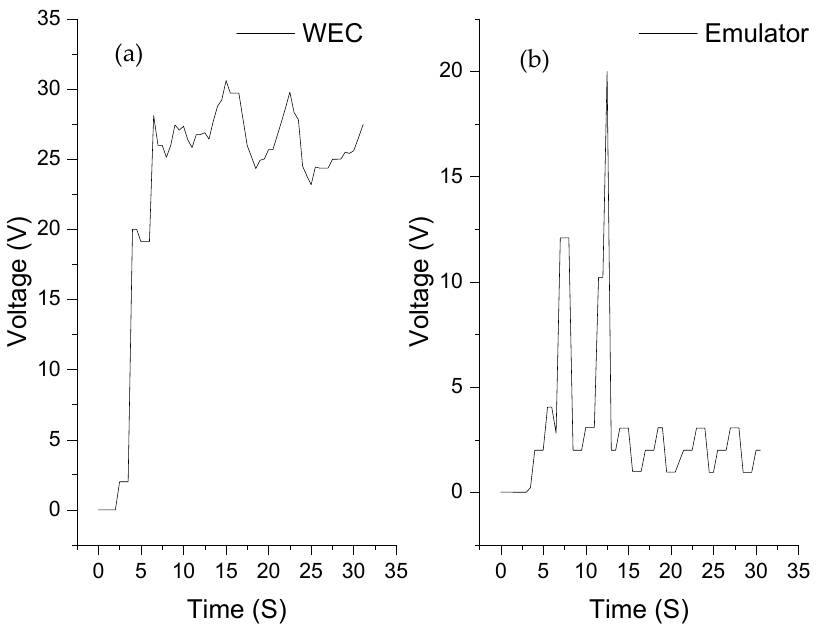
Figure 7. Output voltage for ( a ) WEC and ( b ) emulator.